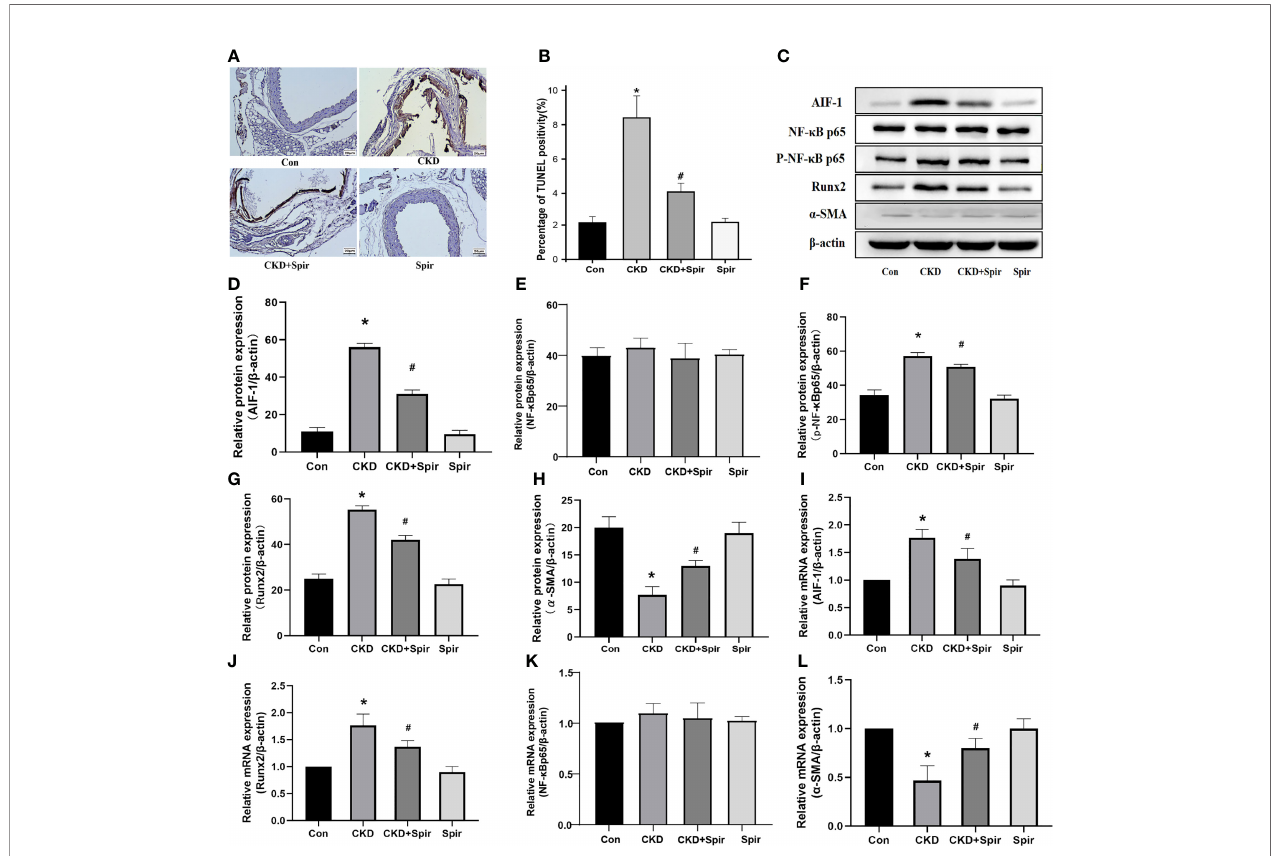
FIGURE 3 | Cell apoptosis in the vascular tissue using TUNEL staining (200X) (A, B) . Western blot and PCR analysis (C – L) . (n=6) (*P<0.05, Control group vs. CKD group; # P<0.05, CKD group vs. CKD+Spir